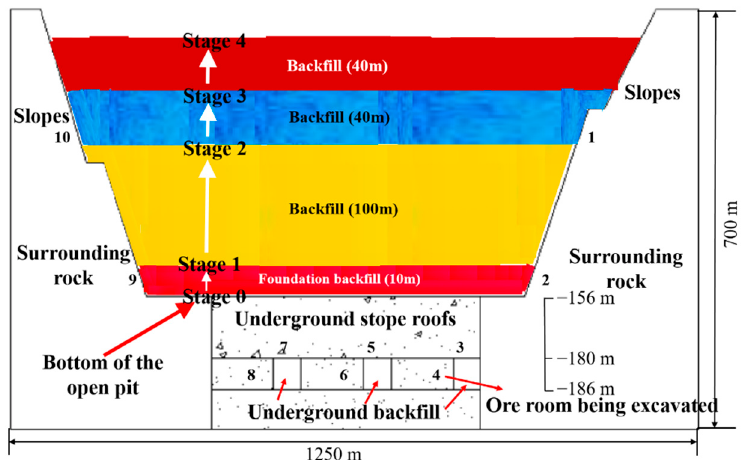
Figure 5. Schematic diagram of backfilling level.